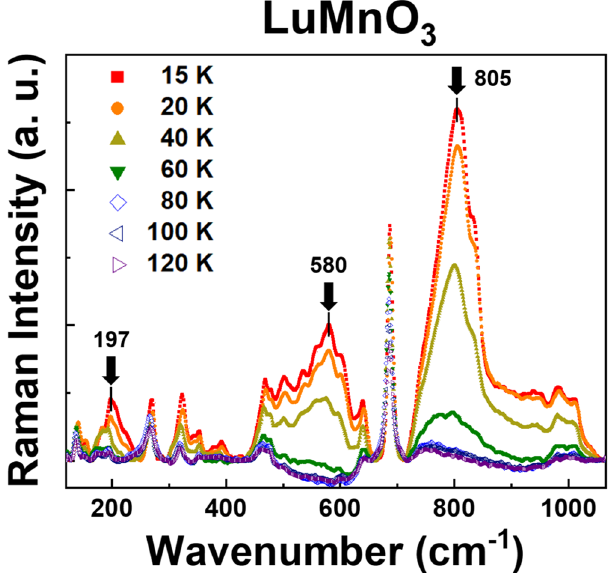
Figure 1. Temperature dependence of Raman spectra of hexagonal LuMnO 3 single crystal in the cross scattering configuration. Several broad peaks (~ 197, 580, 805 cm −1 ) are prominent at low temperatures, and disappear above 80 K (~ T N